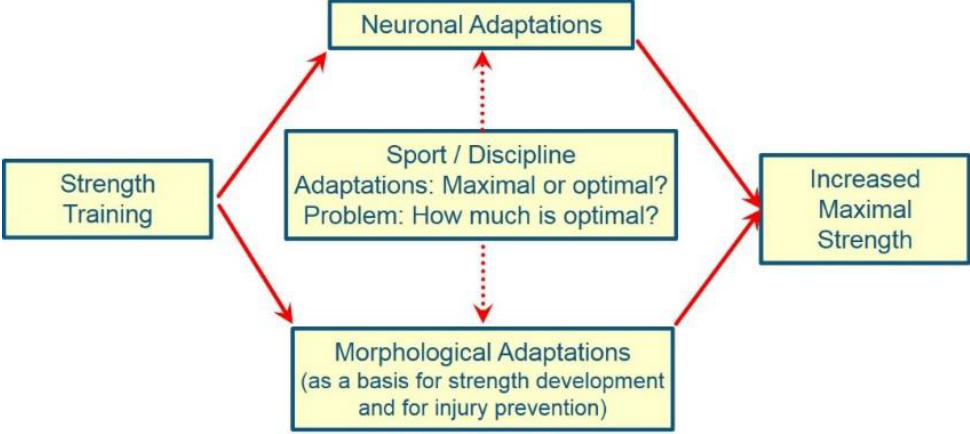
Figure 1. Maximum strength